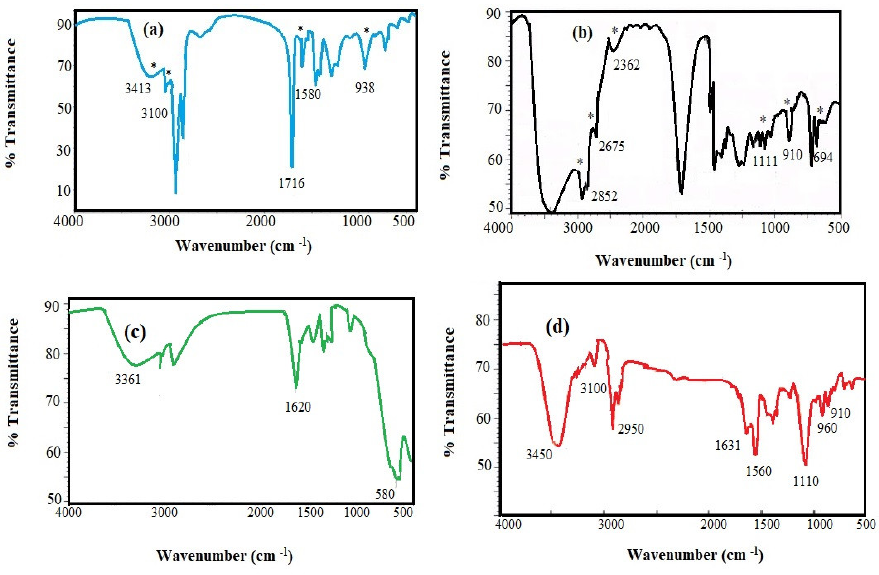
Figure 1. FTIR spectra of ( a ) LNA, ( b ) ELNA, ( c ) ELNA-Fe 3 O 4 and ( d ) ELNA-Ag NPs.